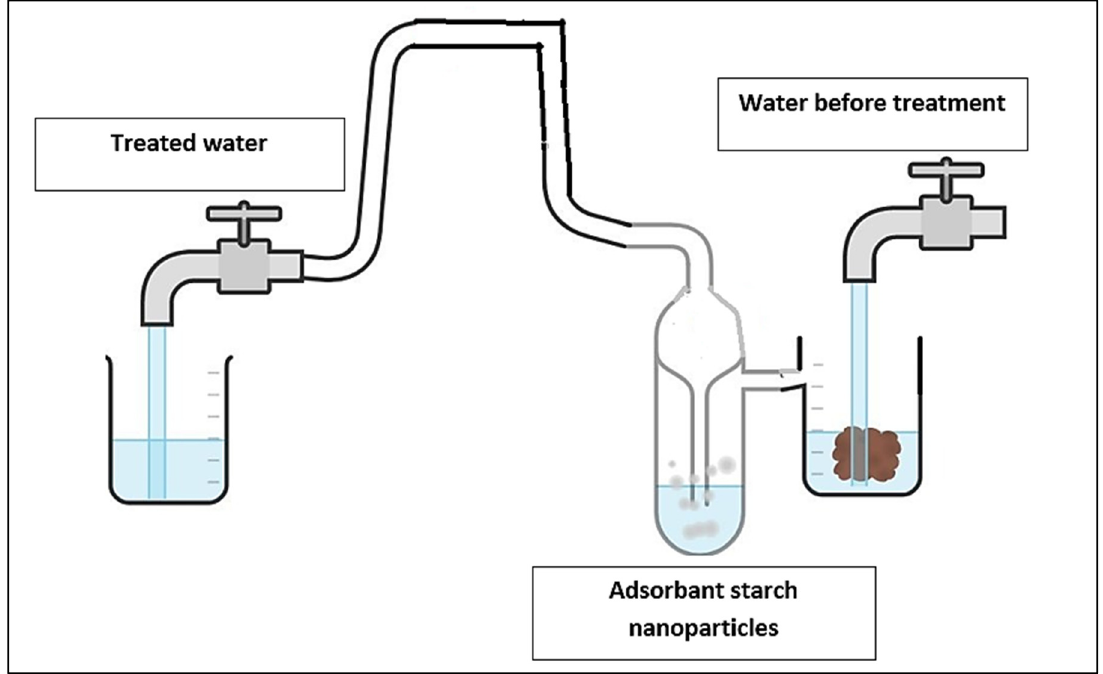
Figure 8. SNPs adsorbents in water treatment.